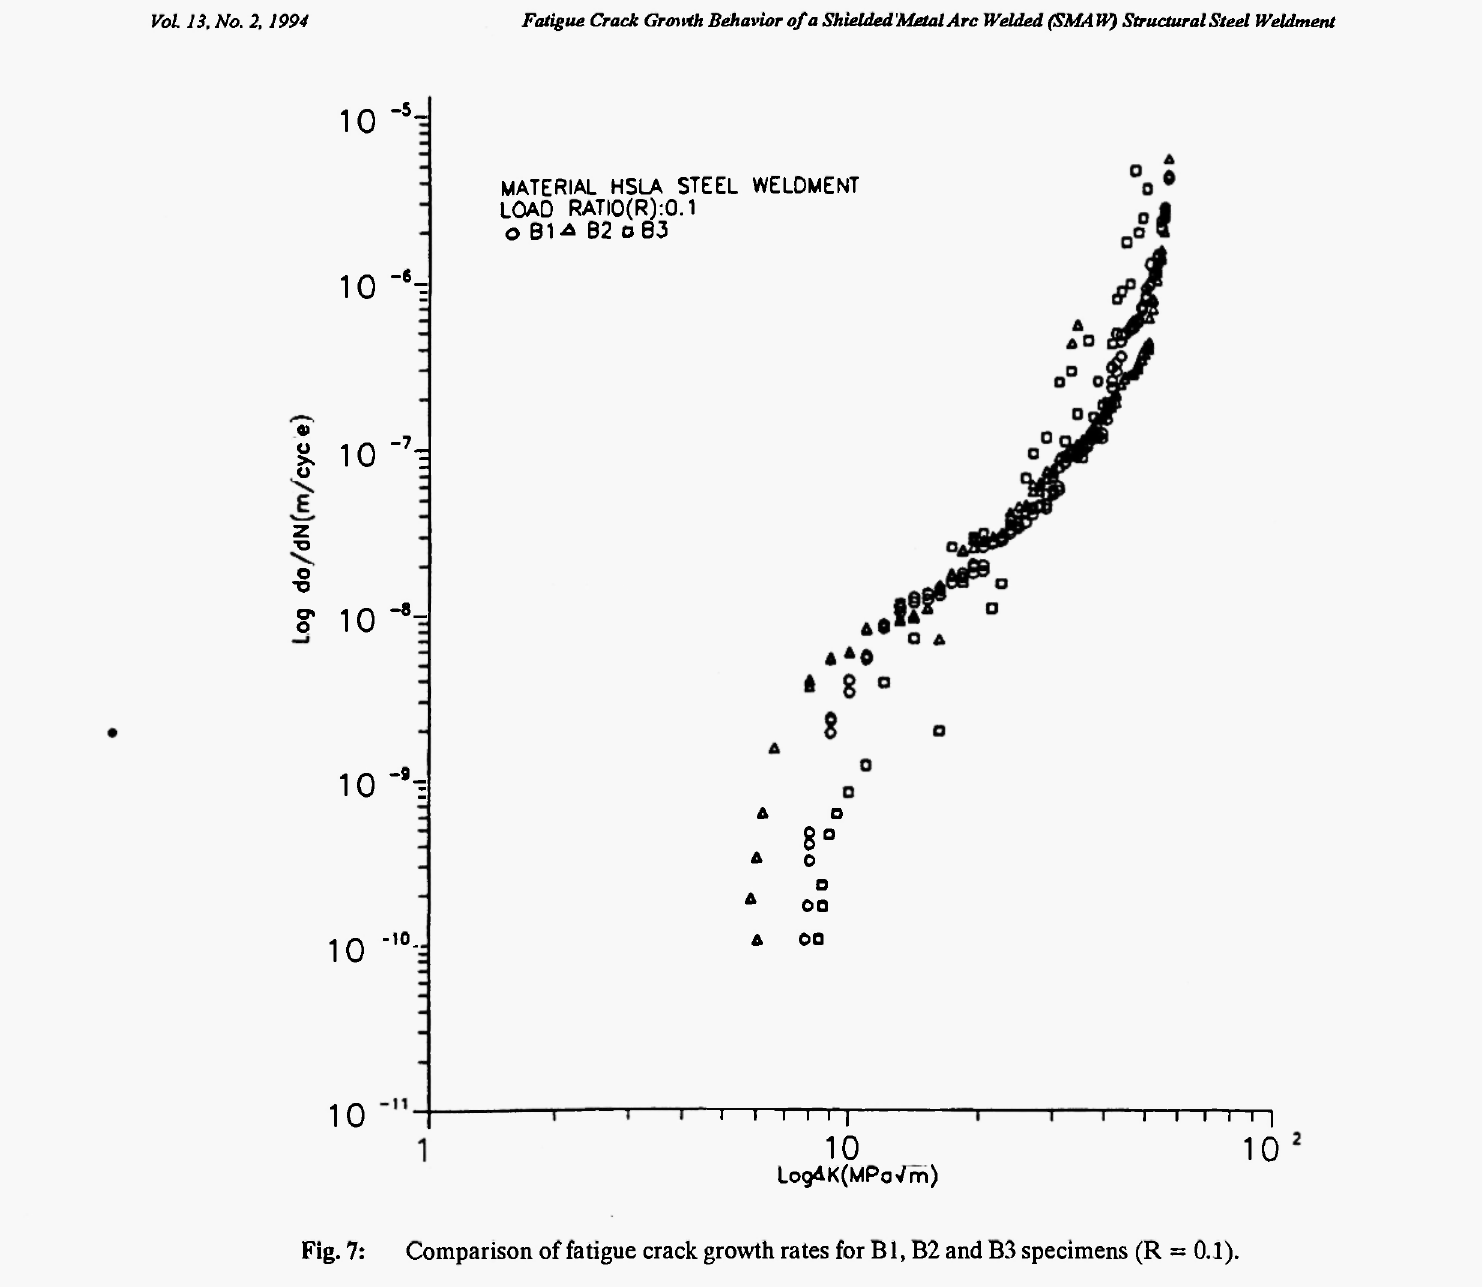
Fig. 7: Comparison of fatigue crack growth rates for Bl, B2 and B3 specimens (R =